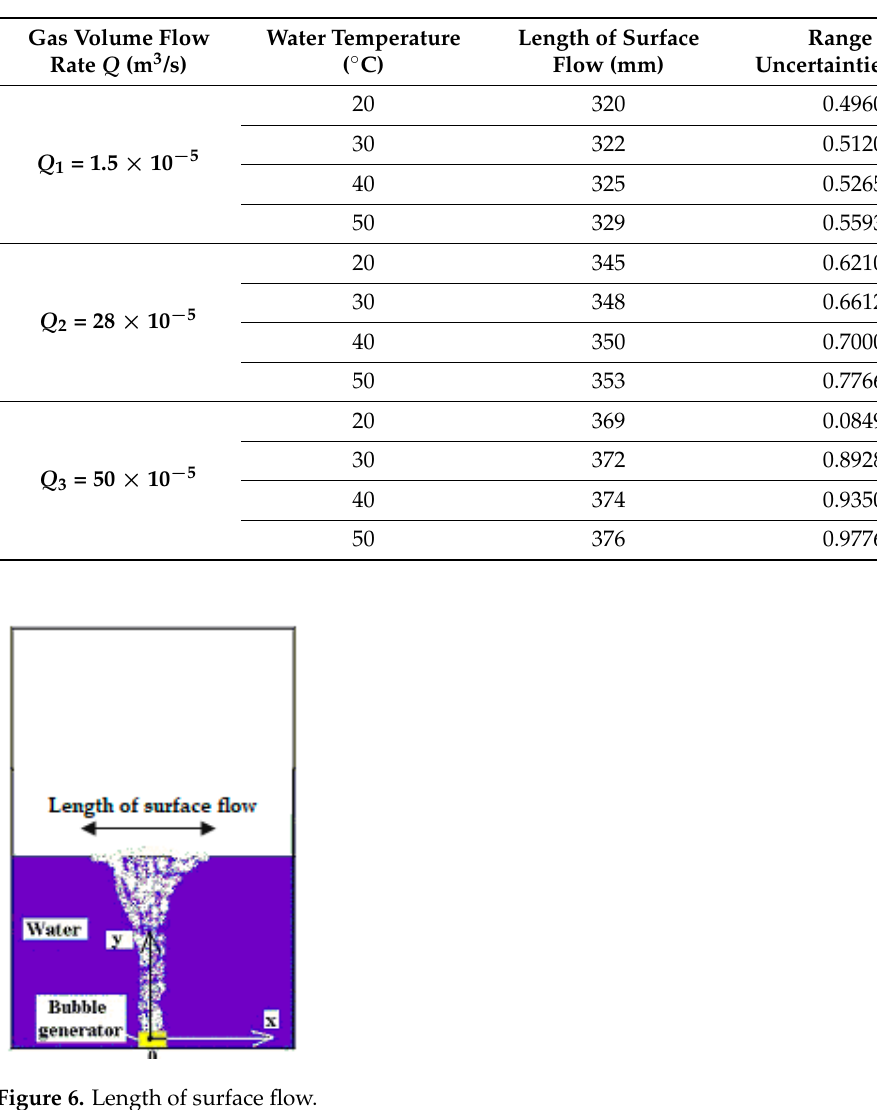
Table 14. Water temperature and length of the bubble plume at the free surface for different gas flow rates.